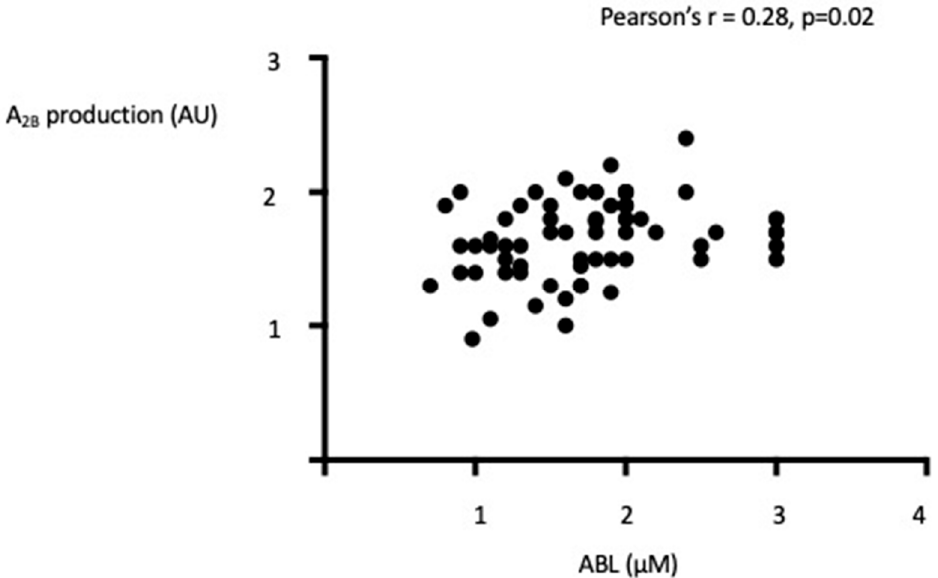
Figure 3. Correlation between A 2B production and ABL in 67 patients with fibromuscular dysplasia. Receiver-operating characteristic (ROC) curves show a good sensitivity/specificity ratio for ABL > 0.85 µmol/L (see Figure 4A). For A 2B R production, ROC curves show a good sensitivity/specificity ratio with a cut off > 1.23 AU (see Figure 4B). Finally, when combining ABL and A 2B R expression, ABL > 0.85 µmol/L and A 2B R production > 1.23 AU give a sensitivity of 89.6% and a specificity of 100%.